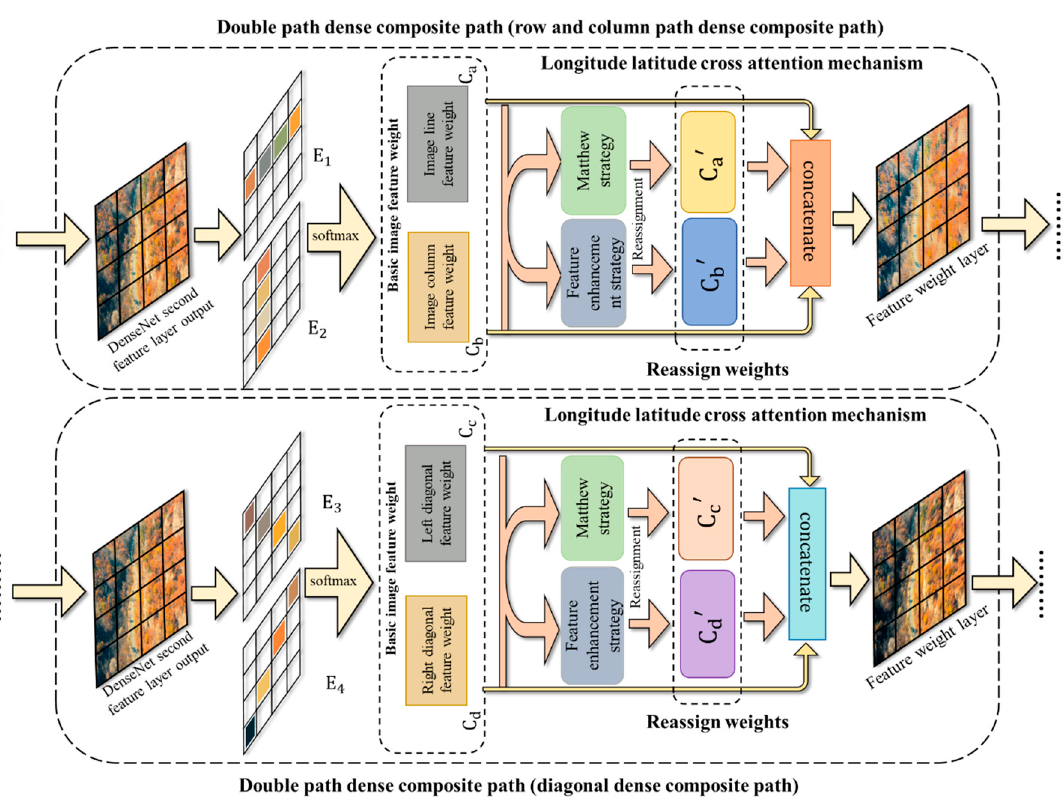
Figure 6. Diagram of the LLAM.